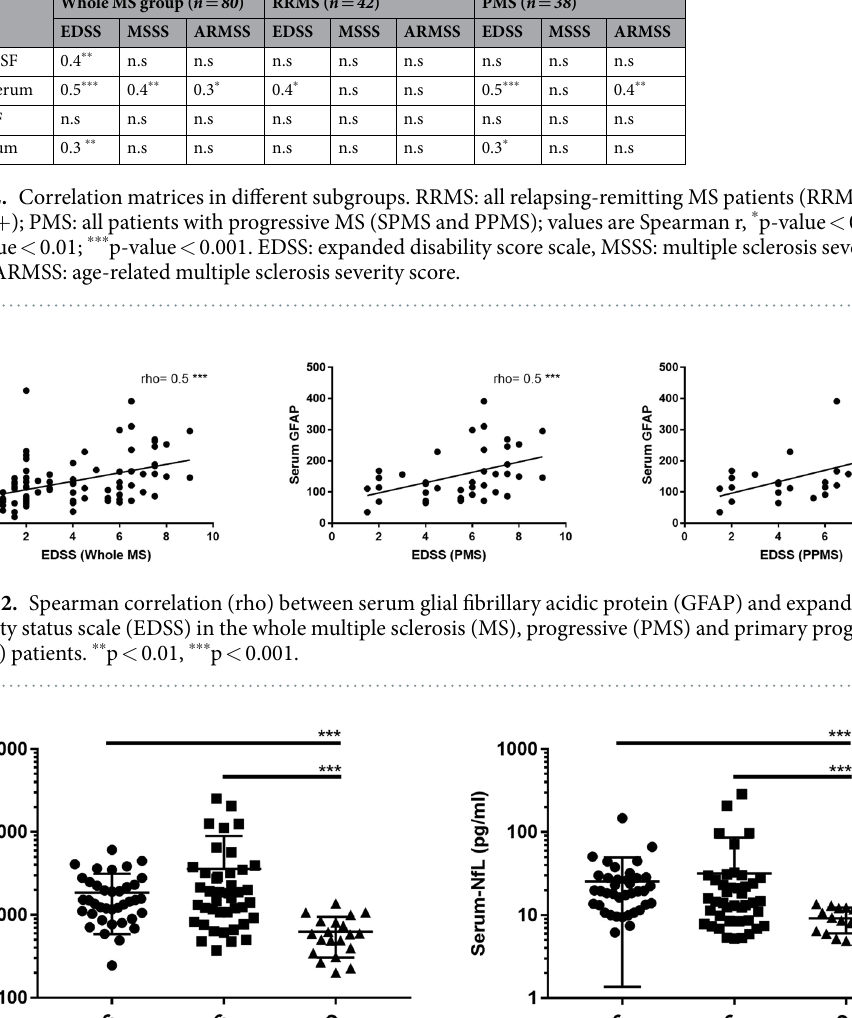
NfL. CSF and serum levels of NfL showed a high correlation in the MS patients and controls ( Spearman rho = 0.7 and 0.6, p < 0.001 and = 0.008, respectively). In contrary to GFAP, NfL levels did not correlate with age or Q alb , except for a weak correlation between serum NfL and age ( Spearman rho = 0.2, p = 0.048). Serum NfL correlated with disease duration ( Spearman rho = 0.4, p < 0.001), but not after correction for age. Concentrations of NfL in CSF and serum were higher in PMS and RRMS (p < 0.001 for all comparisons) com- pared to controls. However, NfL in CSF and serum did not differ between progressive and relapsing MS course (Fig. 3). Correlations with the different clinical parameters are listed in Table 2. GFAP in correlation to NfL. In the whole MS group and in PMS patients, GFAP correlated with NfL in CSF ( Spearman rho = 0.3 and 0.5, p = 0.007 and 0.003, respectively) and serum ( Spearman rho = 0.4 for both, p < 0.001 and = 0.01, respectively). The correlation was even stronger in PPMS ( Spearman rho = 0.6, p = 0.003 for CSF and 0.5, p = 0.007 for serum values) (Fig. 4). In RRMS patients, only serum GFAP and NfL showed a significant correlation ( Spearman rho = 0.4, p = 0.01).